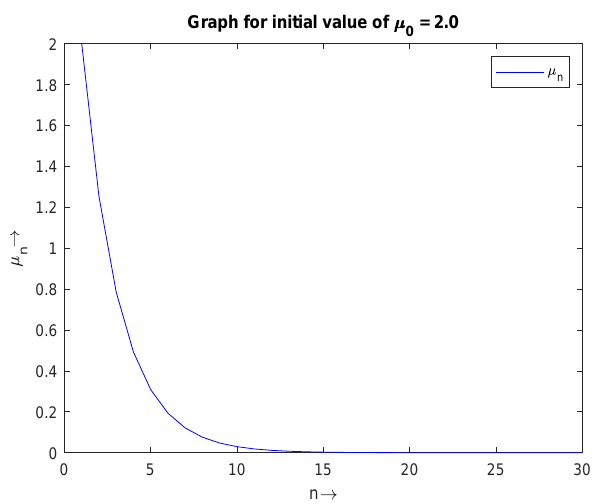
Figure 2. The convergence of { µ n } with initial value µ 0 =